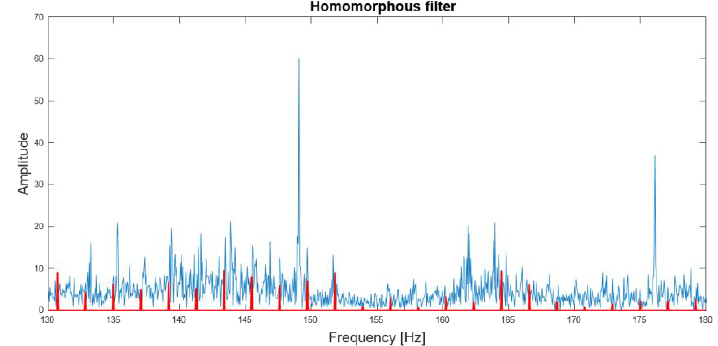
Figure 7. Example of: ( a ) Spectra of the harmonic and non-harmonic part of the signal and ( b ) zoom of spectra corresponding to the harmonic part of the signal.